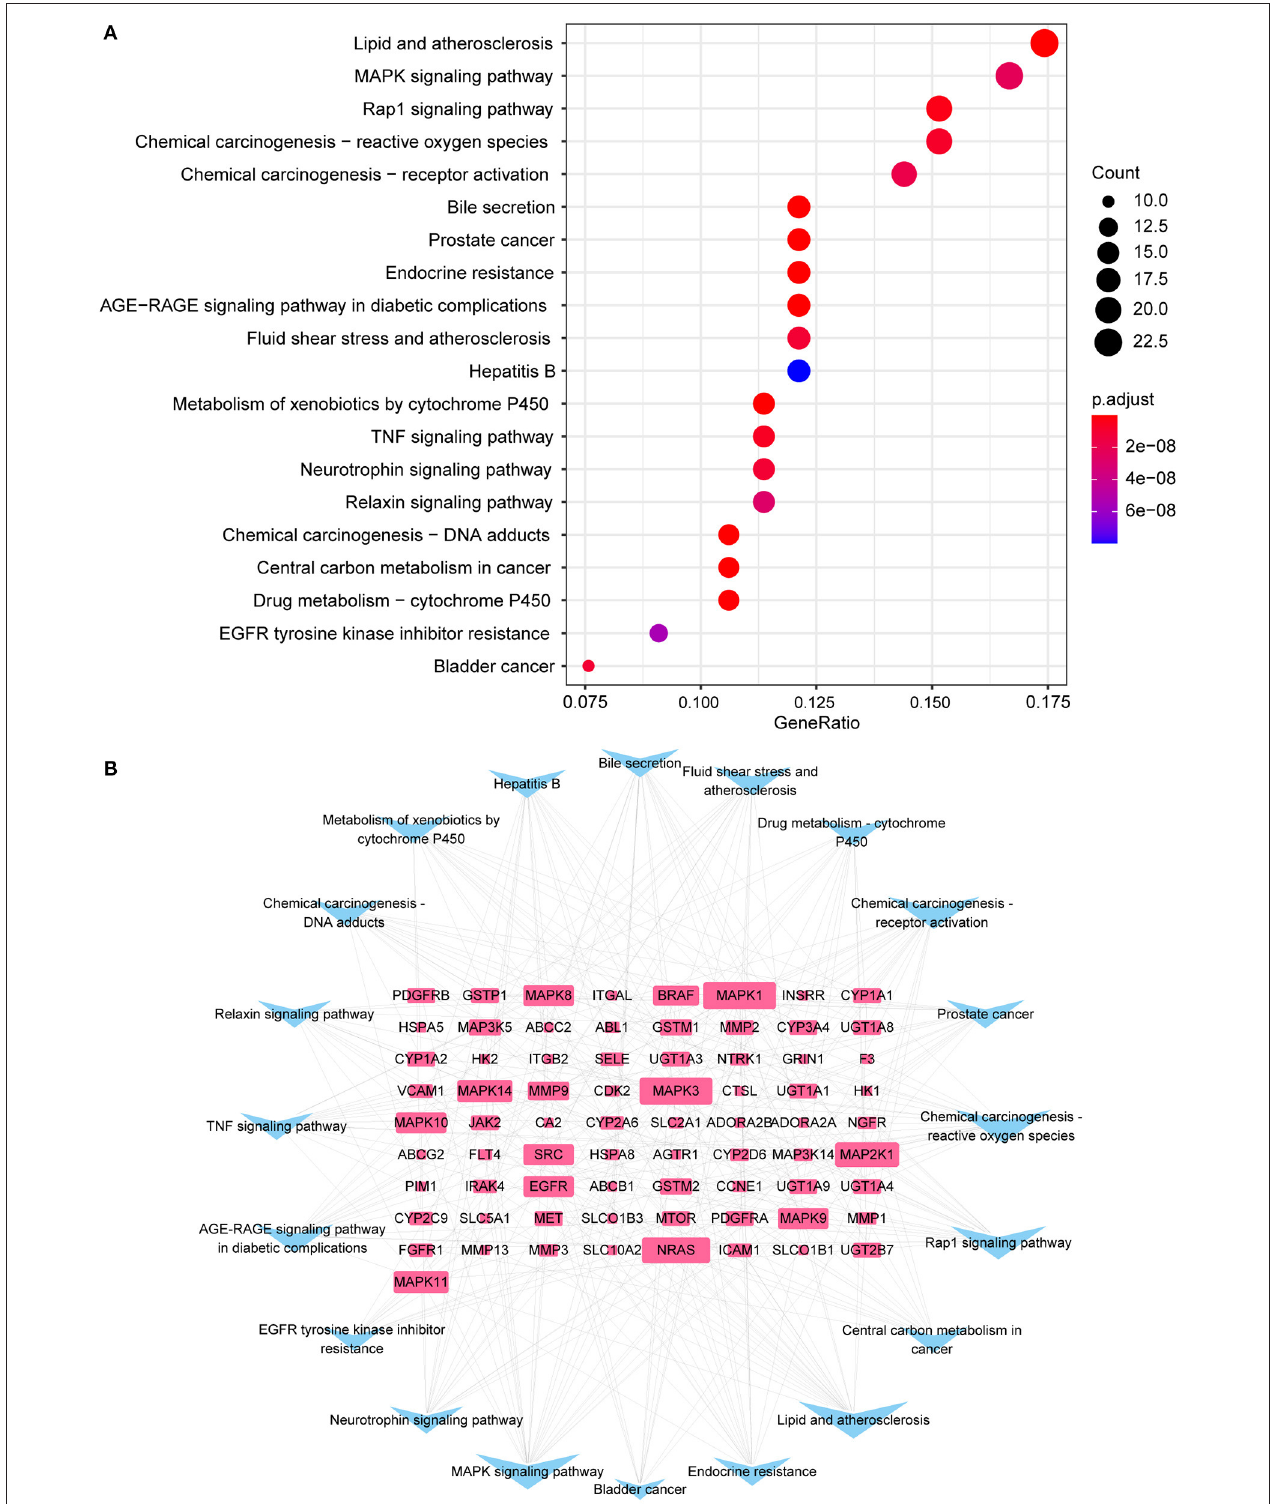
FIGURE 4 | KEGG enrichment analysis. (A) The top 20 enriched pathways; (B) Interaction network of 73 targets (blue) and top 20 pathways (pink) to indicate pathways-targets network.